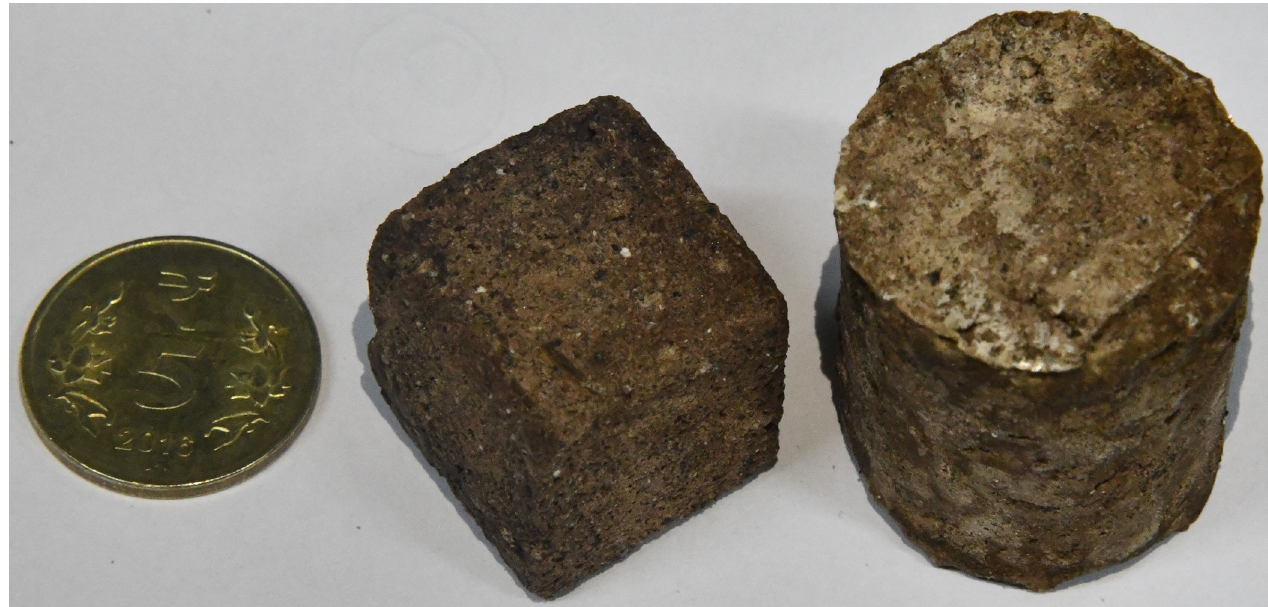
Fig 2. Representative image of consolidated samples using MSS. Such structures have been termed space bricks.